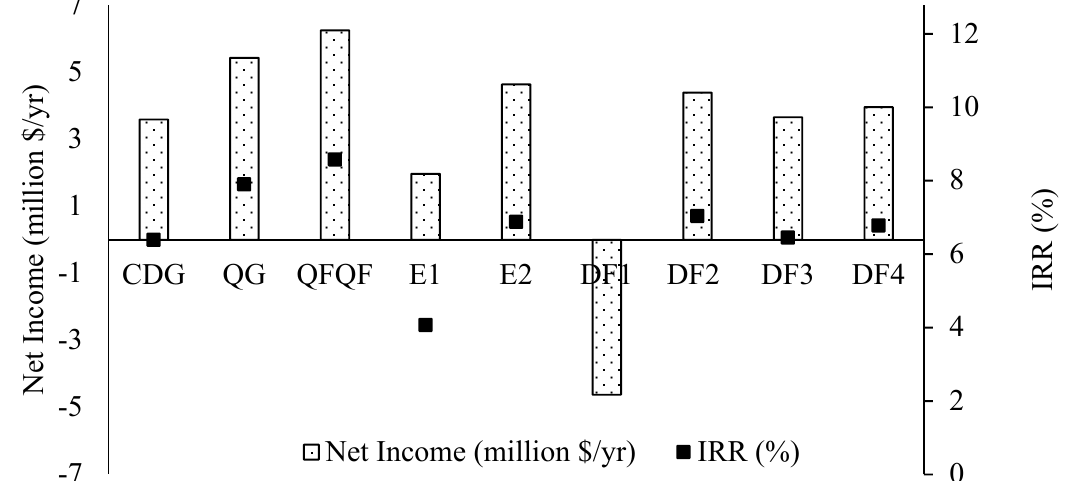
Figure 4. Summary of net annual income and internal rate of return for conventional and modified dry grind processes. IRR for DF1 could not be estimated due to negative annual income.